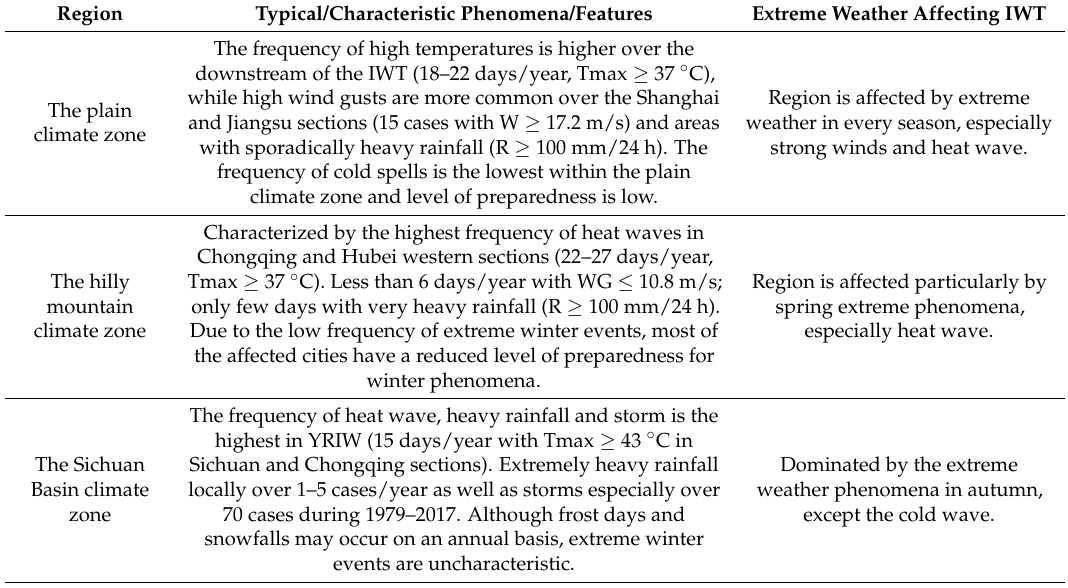
Table 3. Characterizations of climate regions based on the analysis of spatial variation in extreme weather affecting